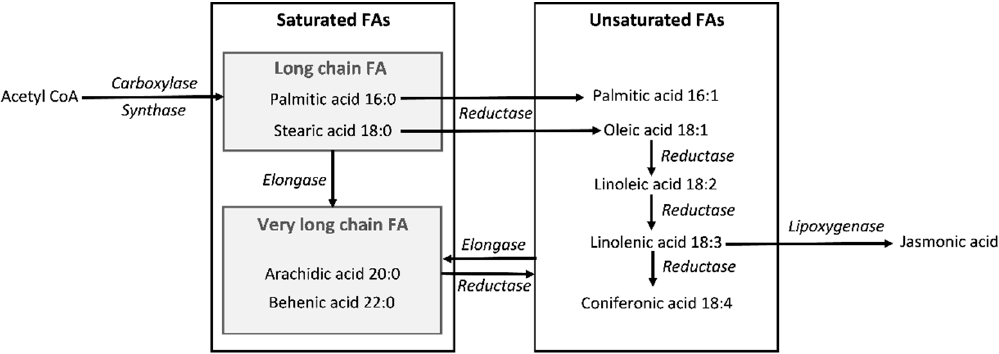
Figure 1. Simplified schematic of fatty acid synthesis adapted from [11,14]. Specific fatty acids are shown as examples and not meant to be a comprehensive list of all fatty acids. Enzymes are shown in italics.